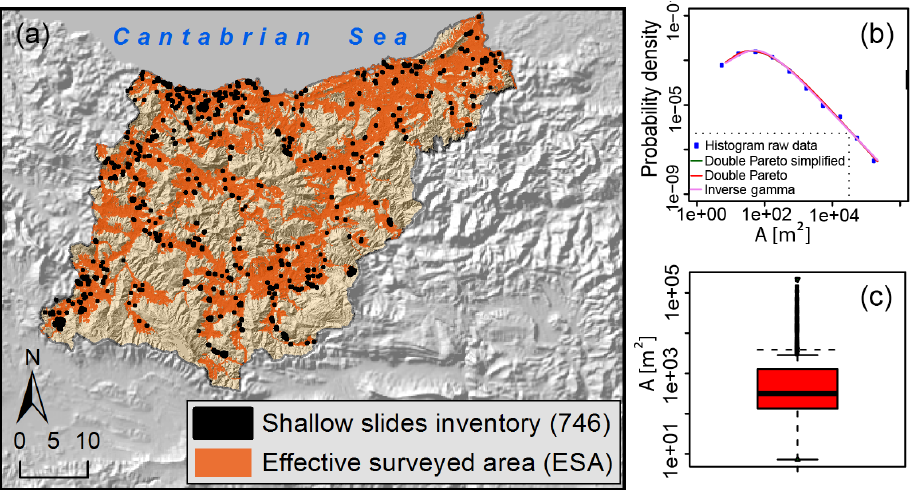
Figure 2. (a) Distribution of the shallow slides inventory along the study area and extension of the effective surveyed area (ESA). (b) Prob- ability density plot of the shallow landslide size (area in m 2 ) distribution. (c) Box plot of the same